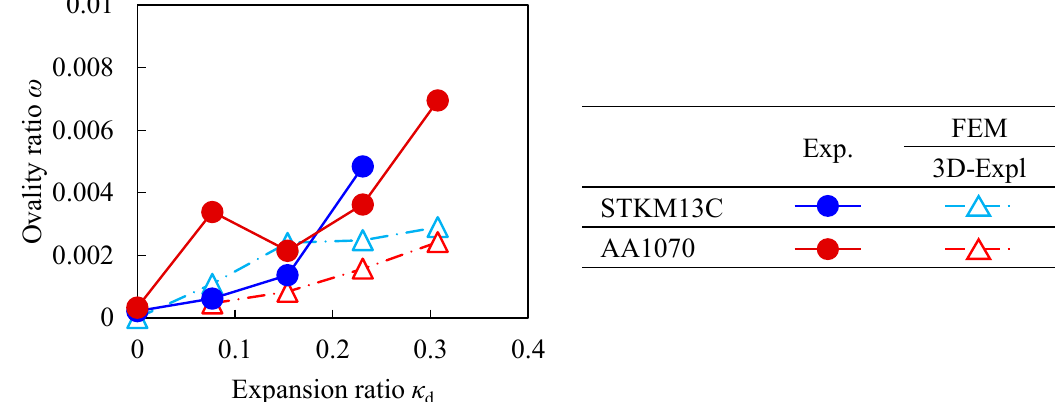
Figure 18. Distribution of thickness change ratio η in hoop direction by drawing process.